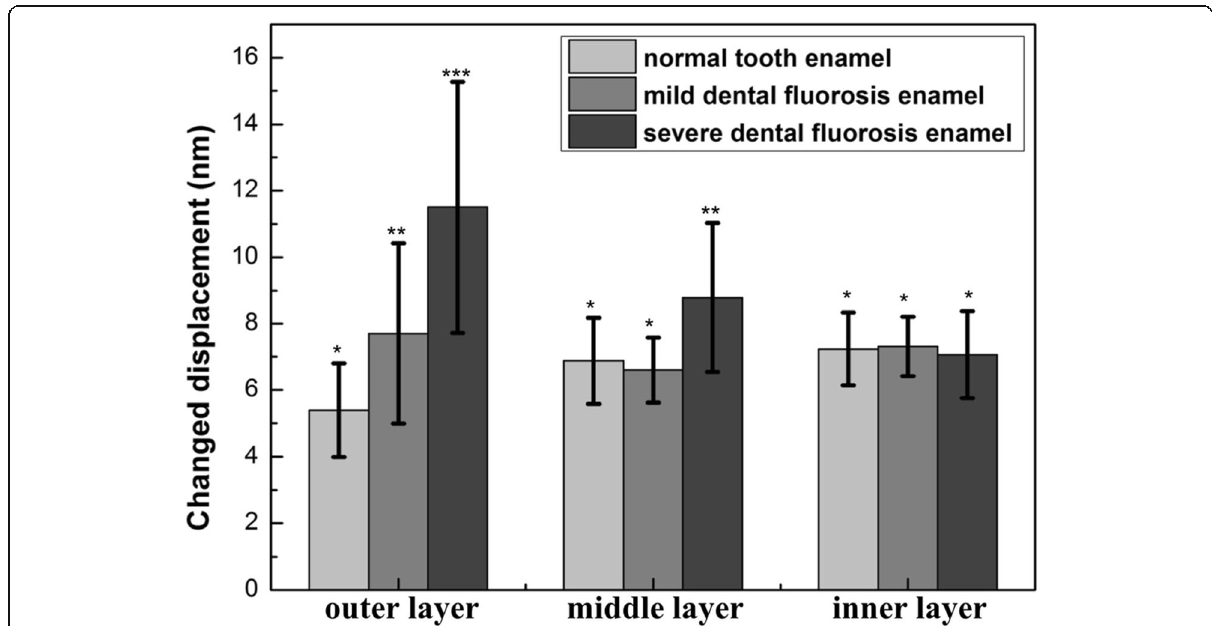
Fig. 4 Nanoindentation creep behavior of the enamel layers of the normal tooth, mild dental fluorosis, and severe dental fluorosis. Identical symbols denote no significant difference in nanoindentation creep behavior among the corresponding layers of the normal tooth enamel, mild